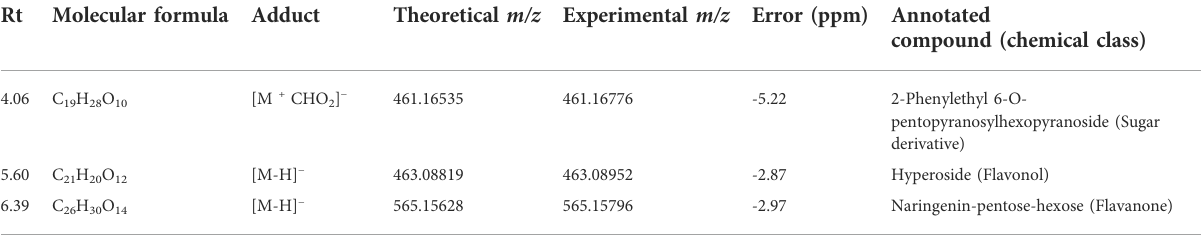
TABLE 2 Annotated VIP responsible for Viscum album subspecies discrimination in negative ionization